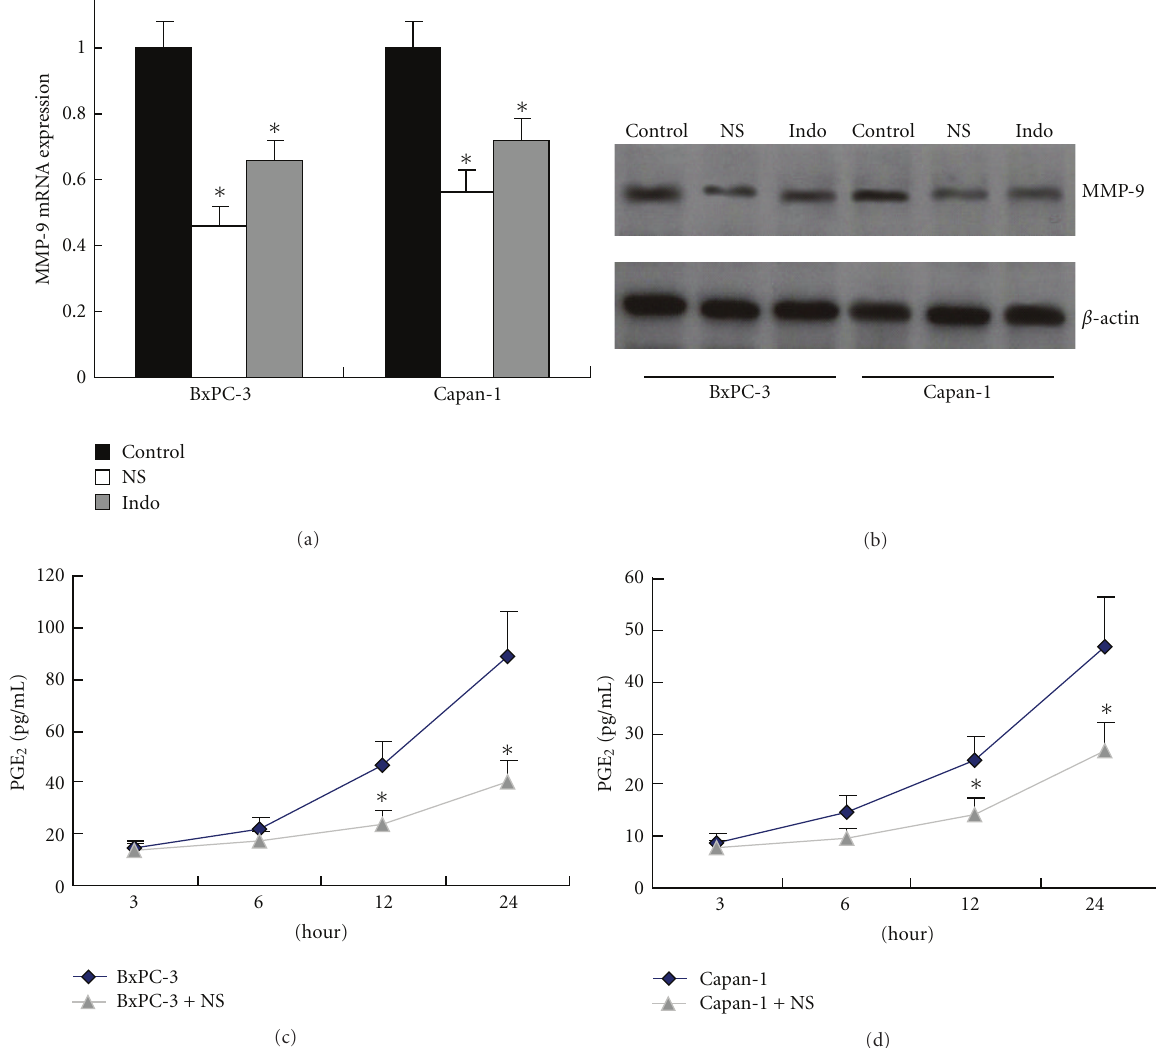
Figure 3: Inhibition of MMP-9 expression by NS398 or indomethacin (a) and (b) MMP-9 expression was inhibited in BxPC-3 and Capan- 1 cells after treatment with NS398 ( ∗ P < 0 . 01, resp., versus control ) or indomethacin ( ∗ P < 0 . 01, resp., versus control). (c), (d) PGE 2 protein levels were decreased in BxPC-3 and Capan-1 after treatment with NS398 for 12 hours ( ∗ P < 0 . 01, resp., versus control) or 24 hours ( ∗ P < 0 . 01, resp., versus control). Data are expressed as mean ± SD, n = 3. NS: NS398; indo: indomethacin.